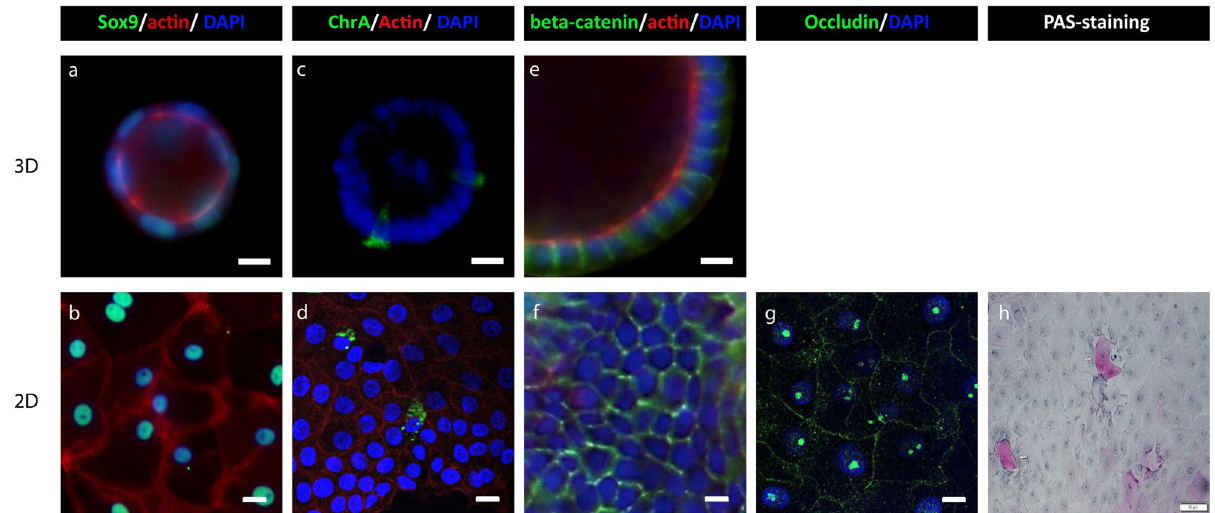
Figure 6. Identification of different cell structures in 3D chicken intestinal organoid and the monolayers. Immunohistochemistry images of 3D and 2D structures of chicken intestinal organoids, processed 2 days after seeding. (a,b) Progenitor cells are visualized with anti-Sox9. (c,d) Enteroendocrine cells are visualized by Chromogranin A. (e–g) Tight junctions are visualized with beta-catenin or occludin (h) Mucus-containing goblet cells are visualized using Periodic Acid Schiff (PAS)-positive cell staining of 2D chicken intestinal organoids. The actin filaments are visualized with rhodamine phalloidin (red), and nuclei are stained with DAPI (blue) Scale bar: 400